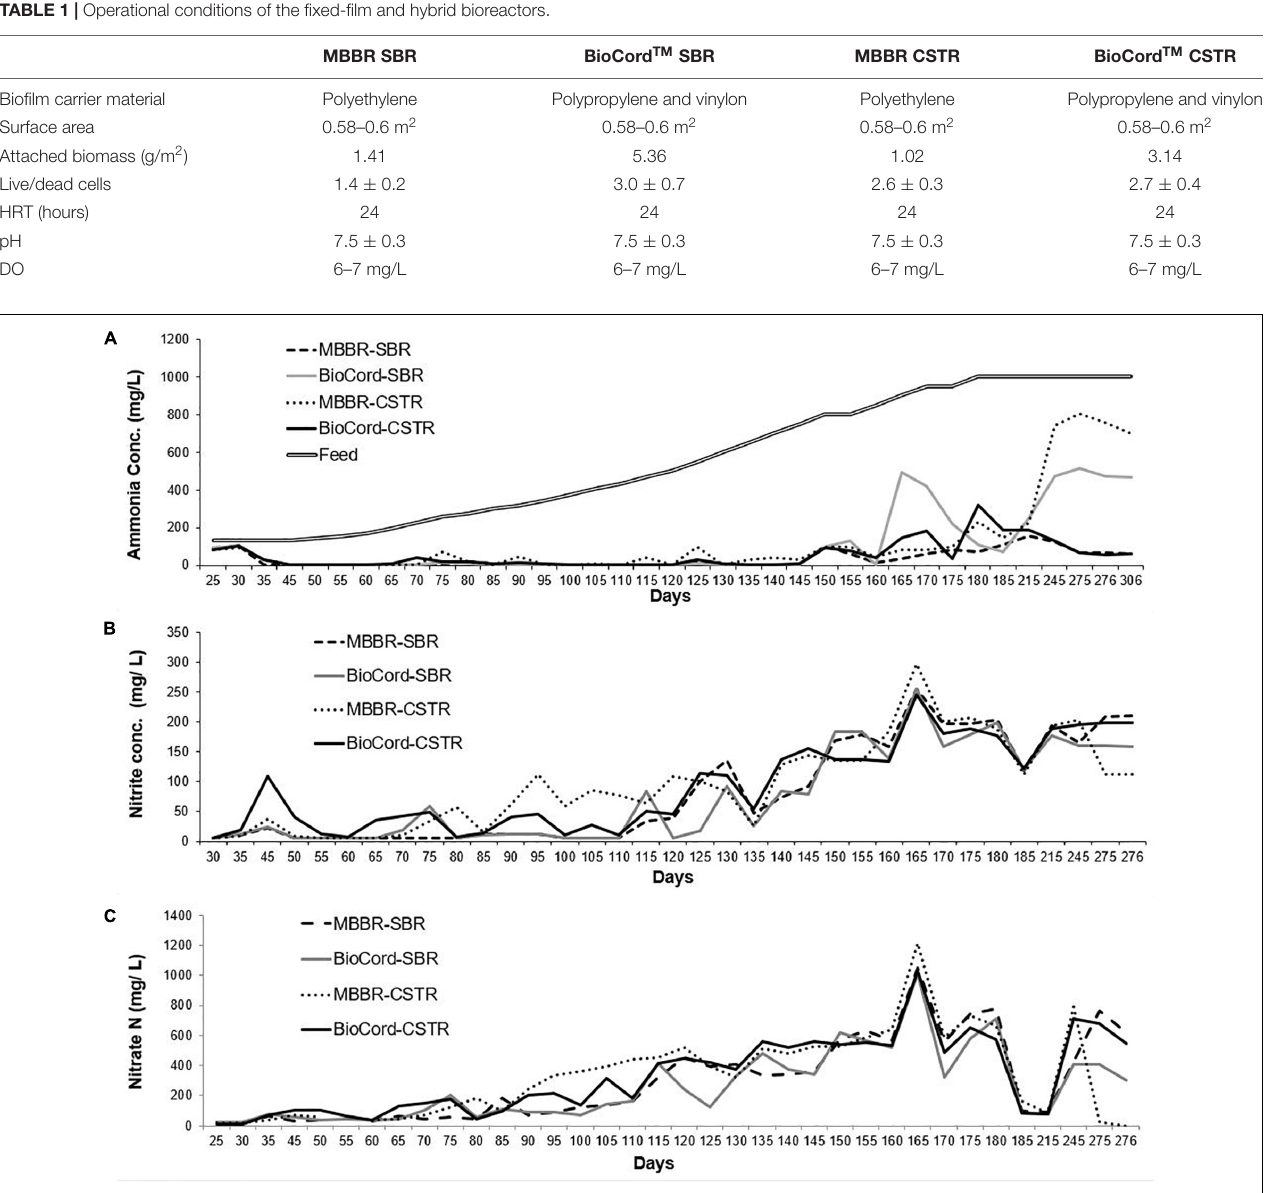
FIGURE 1 | (A) Ammonia concentration in the synthetic feed and the final effluents of all bioreactors. (B) The nitrite accumulation in the final effluent, and (C) final nitrate effluent concentrations in al